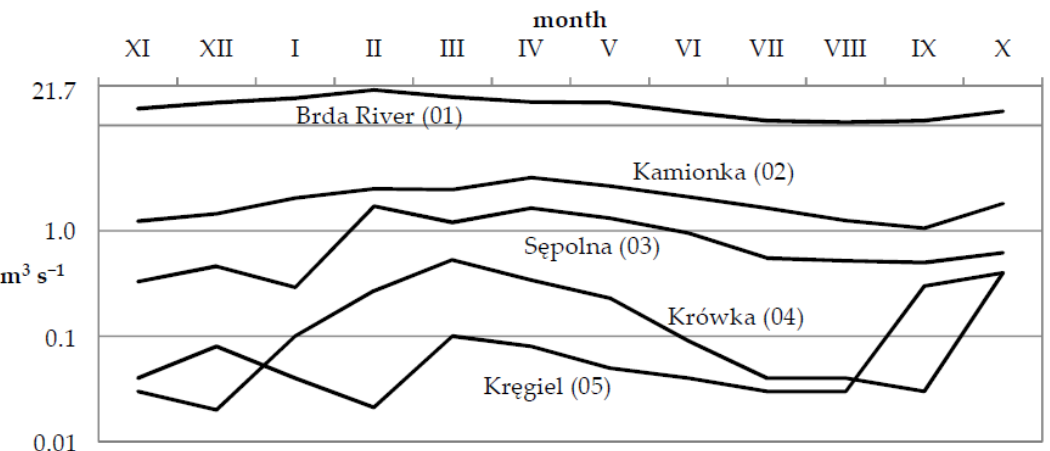
Figure 2. Discharges of main inflows to the Koronowski Reservoir in the hydrological year 2015 ([24] and own research [25]).